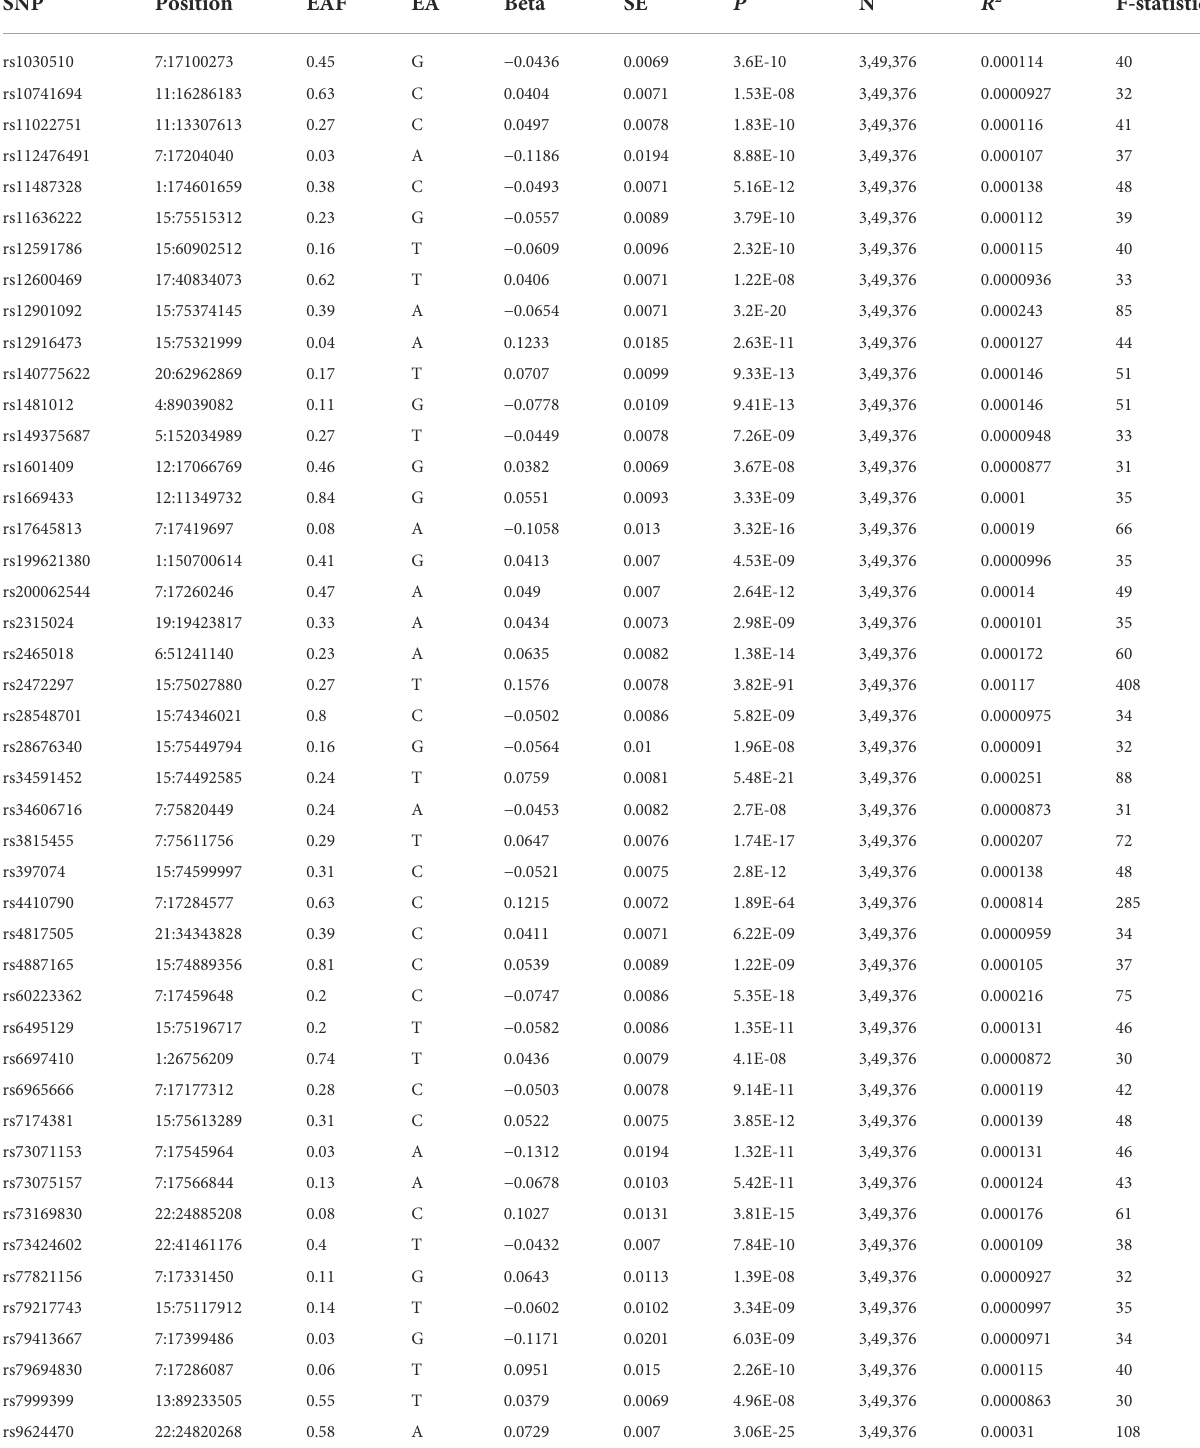
TABLE 1 Characteristics of tea consumption-associated